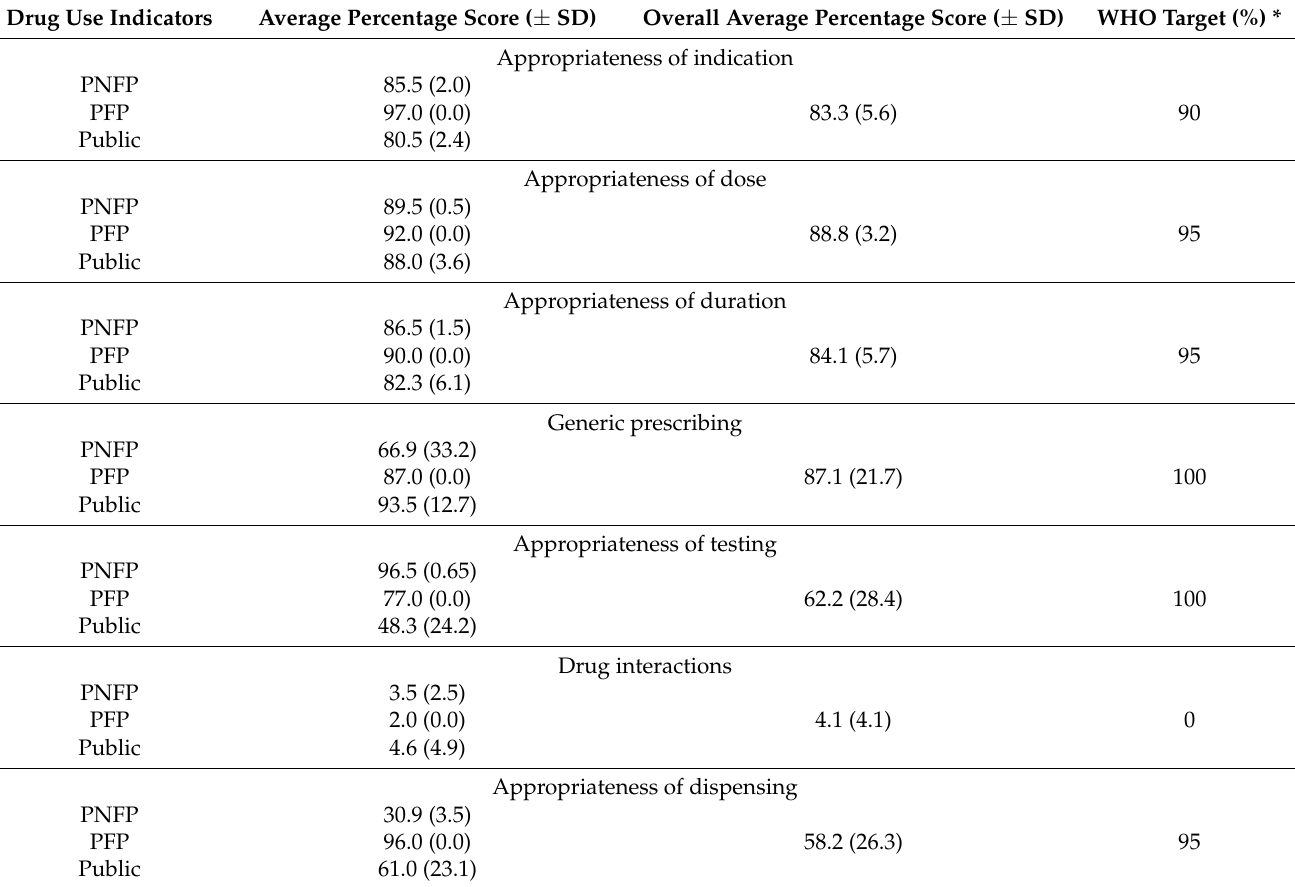
Table 2. Appropriateness of ceftriaxone utilization based on health facility